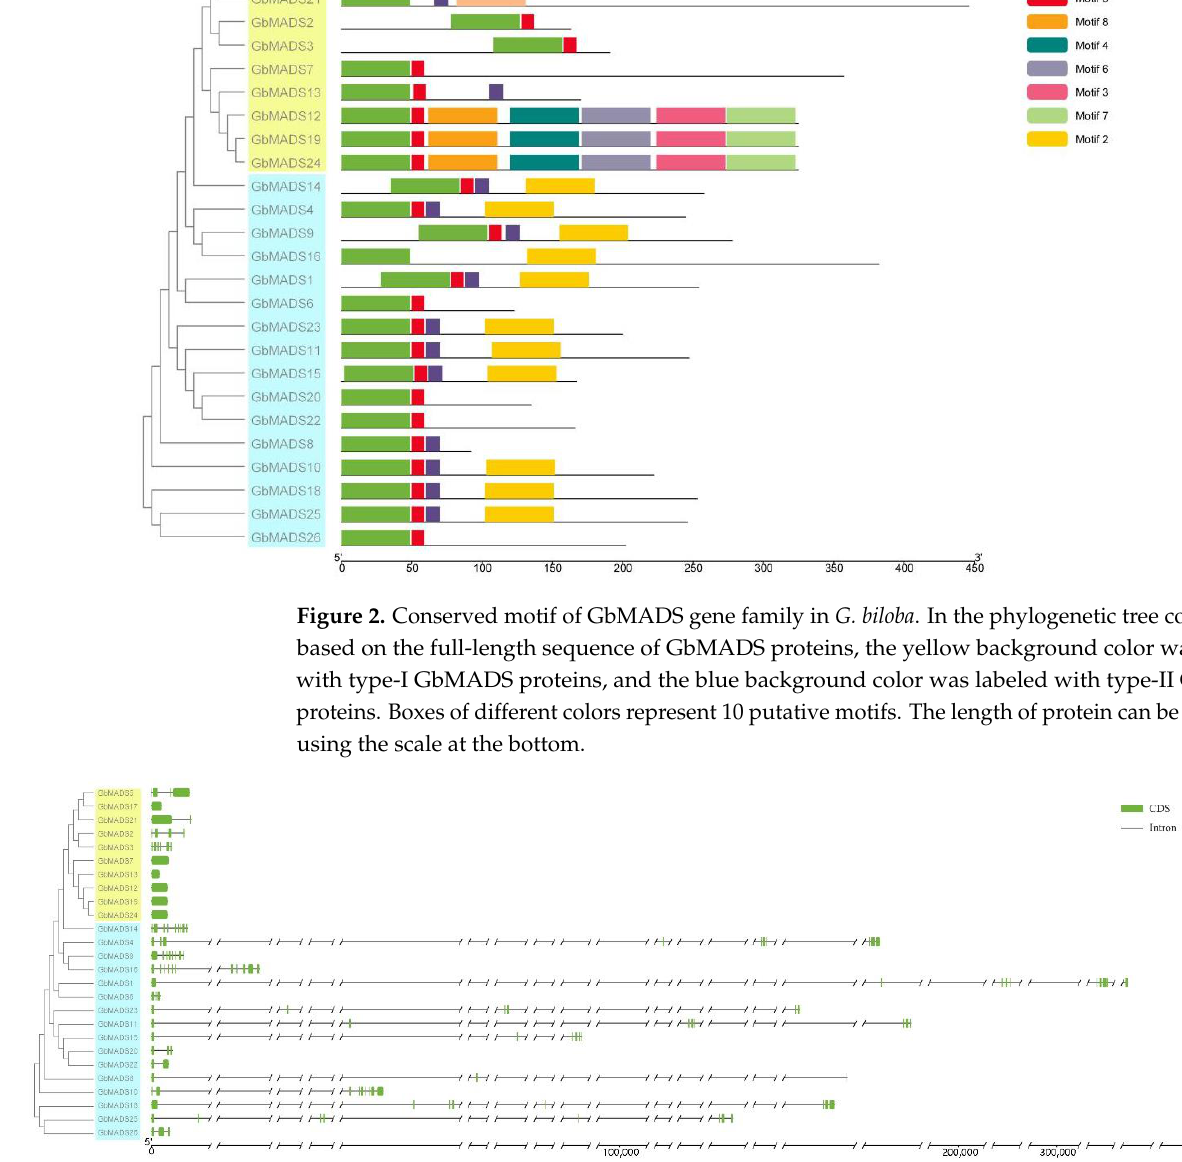
Figure 3. Gene structures of GbMADS gene family in G. biloba . In the phylogenetic tree constructed based on the full-length sequence of GbMADS proteins, the yellow background color was labeled with type-I GbMADS proteins, and the blue background color was labeled with type- Ⅱ GbMADS proteins. CDS and intron were represented by green boxes and black lines, respectively. Because the length of some GbMADS genes is too long, the intron region is partially cut, and the cut part is separated by two slashes.